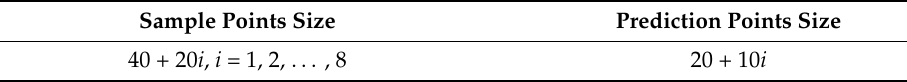
Table 3. Experimental designs for all test